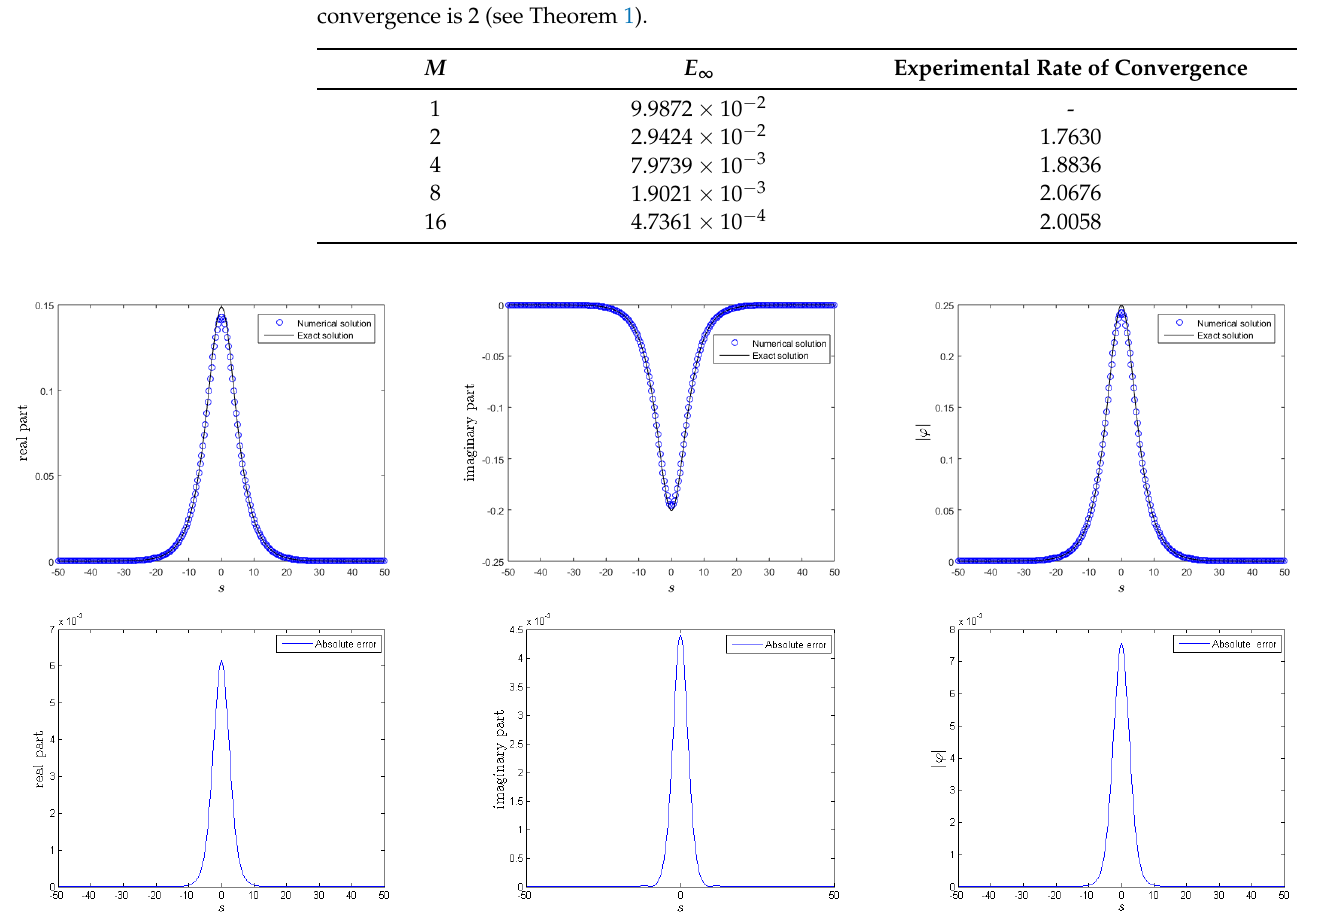
Figure 1. The solution and the absolute error at M = 128, T = 1 and ∆ τ = 0.001 for Test Problem